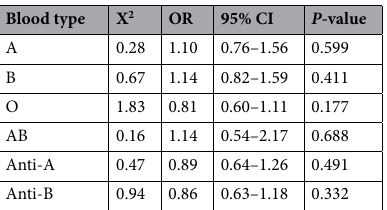
Table 2. Comparison of ABO blood group distributions and antigens present between COV + ICU- and COV +